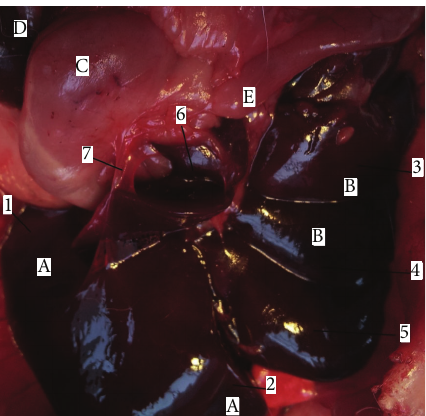
Figure 4: Morphology of rat liver ( facies visceralis ). 1: lobus hepatis sinister lateralis , 2: lobus hepatis sinister medialis , 3: lobus hepatis dexter lateralis , 4: lobus hepatis dexter medialis , 5: lobus quadratus , 6: lobus caudatus , 7: lig. hepatogastricum , A: lobus hepatis sinister , B: lobus hepatis dexter , C: ventriculus , D: lien , and E: intestinum